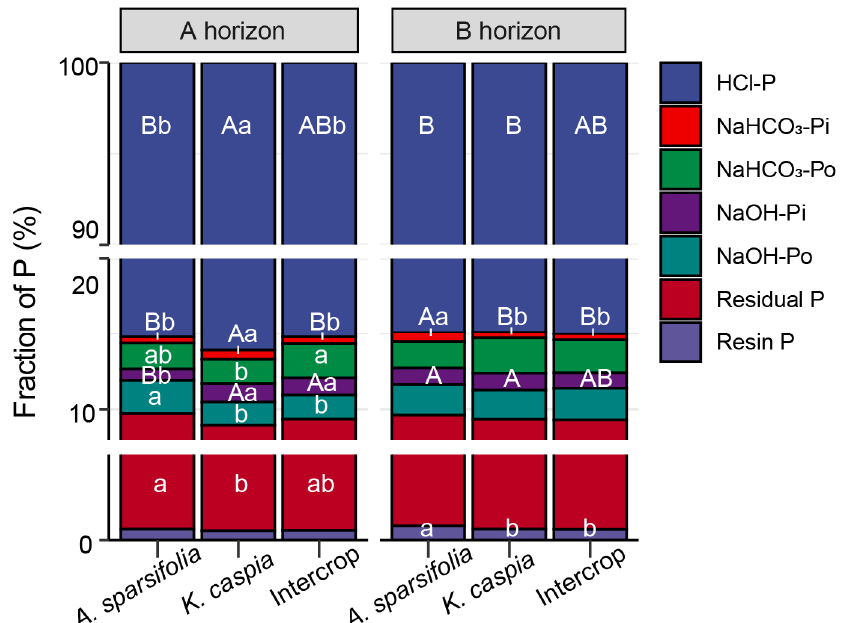
Figure 4. Percentages of different P fractions oftotal P (the sum of all P fractions) in different soil horizons (A or B; depth) in different plant communities ( Alhagi sparsifolia (legume) monoculture, Karelinia caspia (non-legume) monoculture, or both species intercropped) (six treatment groups). Dif- ferent capital letters indicate significant differences at p < 0.05 among all six treatments, and different lowercase letters indicate significant differences at p < 0.05 among different plant communities within each soil horizon.